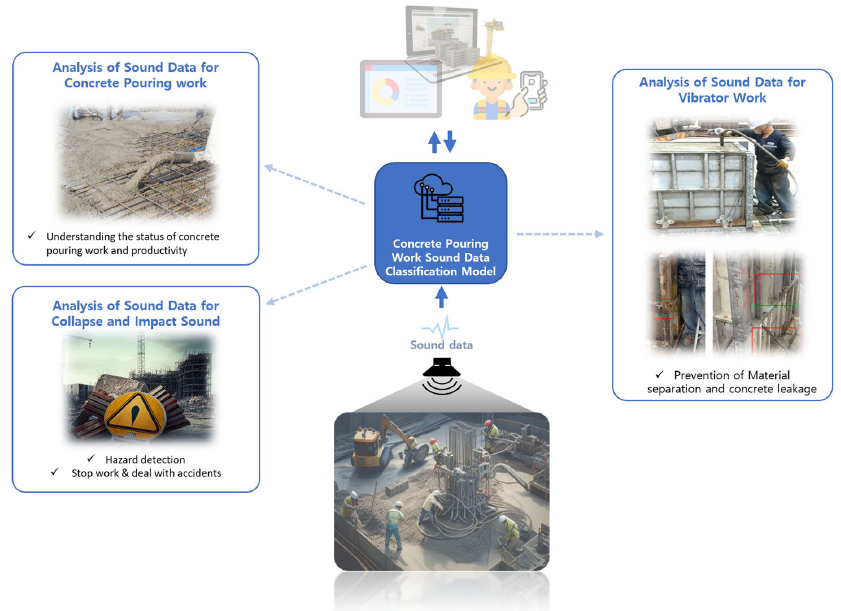
Figure 14. Utilization of the proposed model at construction sites.